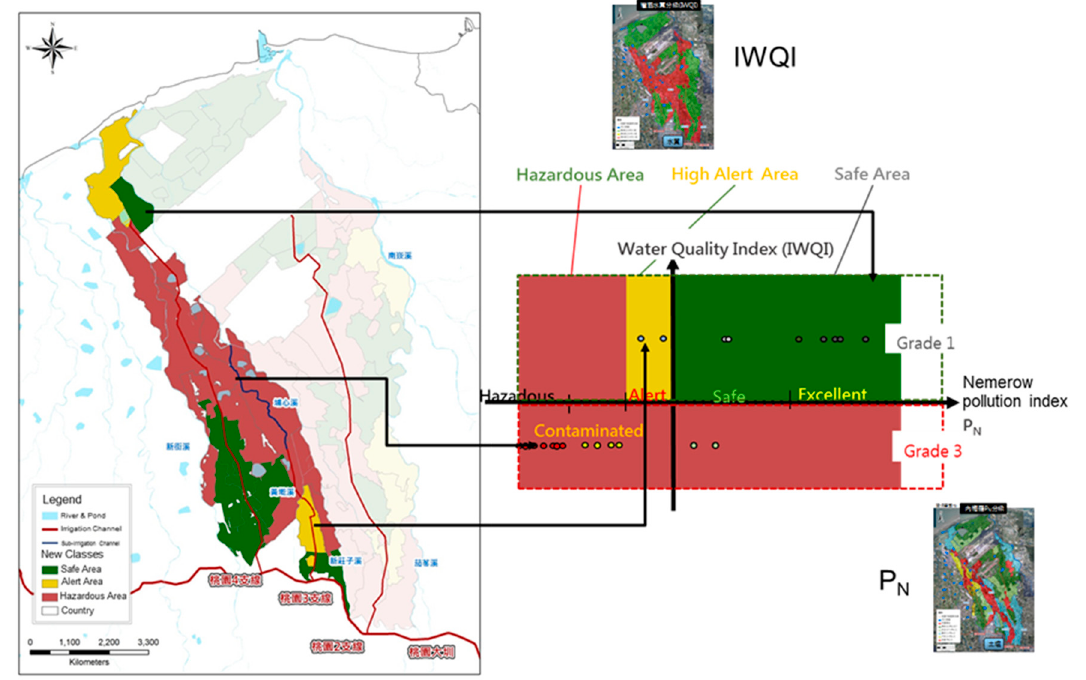
Figure 6. An example of classification results using the hierarchical management strategy in the pilot area. (red represents hazardous areas, yellow represents high alert areas and green represents safe areas). P N : Nemerow Pollution Index; IWQI: Irrigation Water Quality